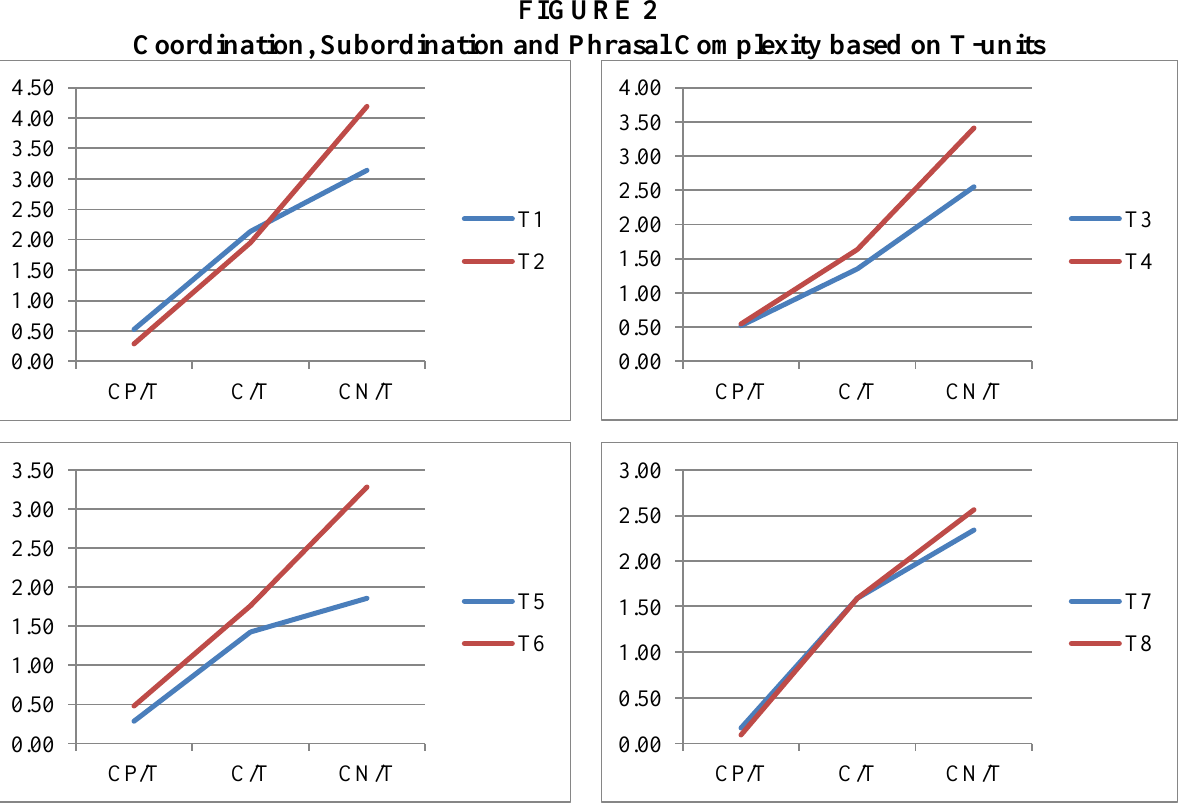
Coordination, Subordination and Phrasal Complexity based on